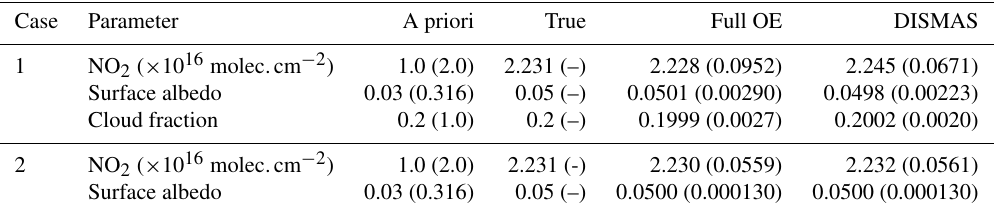
Table 1. Comparison between DISMAS and full optimal estimation (OE) retrievals of the total NO 2 column in a partly cloudy scene (cloud fraction 0.2, Lambertian cloud albedo 0.8) with a reflecting surface. In Case 1 all three parameters are retrieved, whereas in Case 2 the cloud fraction is fixed and only NO 2 column and surface albedo are retrieved. The a priori and retrieval errors are given between brackets. Case Parameter A priori